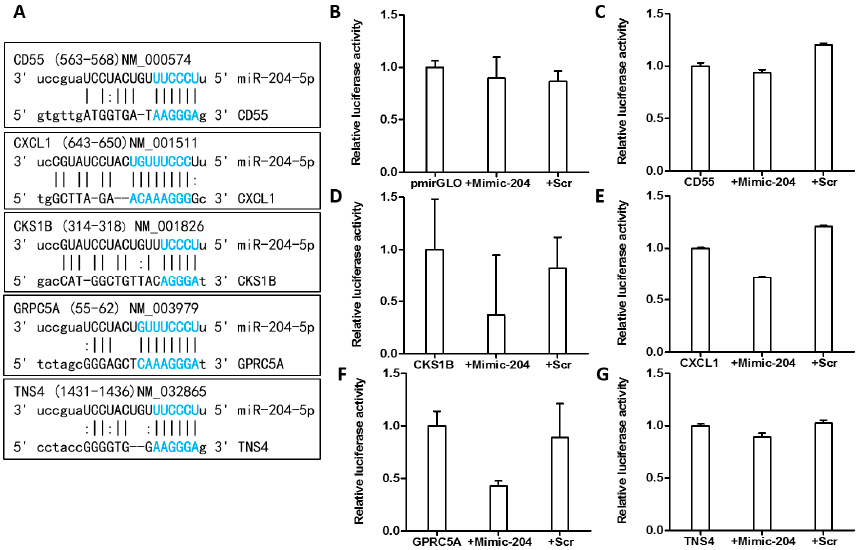
Figure 6. MiR-204 targets CKS1B , CXCL1 , and GPRC5A in gastric cancer cells. ( A ) Predicted target sites (shown in blue) of miR-204 target genes. All the target regions were predicted by miRanda, PITA and RNAhybrid. Luciferase activity in AGS cells co-transfected with either ( B ) empty luciferase vector pmiRGLO as positive control or the construct containing 3 ′ UTR of five target genes ( C ) CD55 , ( D ) CKS1B , ( E ) CXCL1 , ( F ) GPRC5A and ( G ) TNS4 and miR-204 mimic (mimic) or scrambled control (scr).